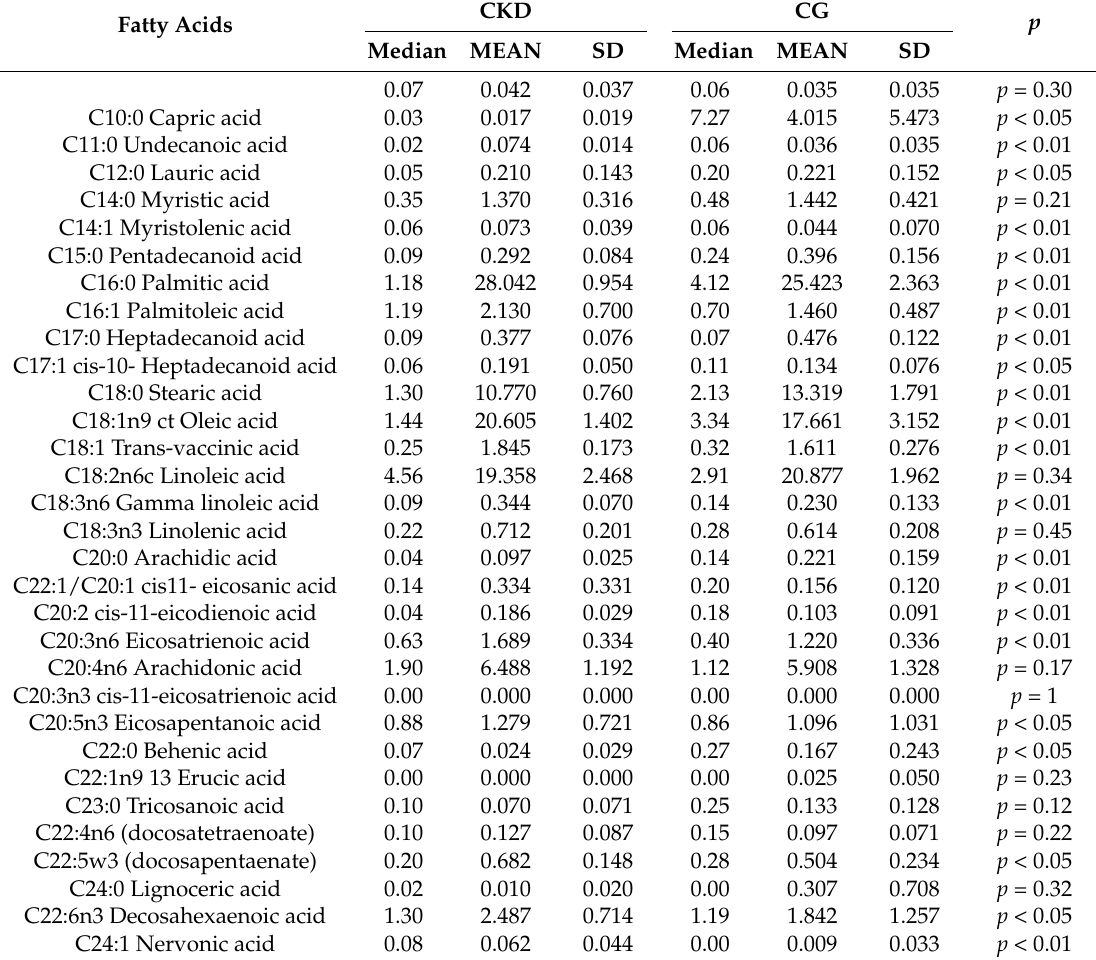
Table 2. Comparison of the content of FAs in chronic kidney disease (CKD) vs. CG [%]. CKD CG Fatty Acids